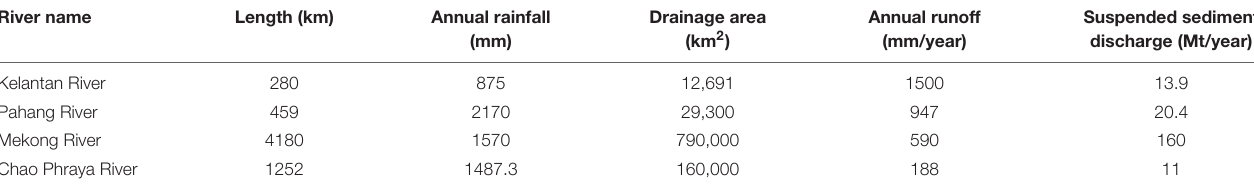
TABLE 1 | Basic information of main rivers drained into the western Sunda Shelf (Liu et al., 2012, 2016). River name